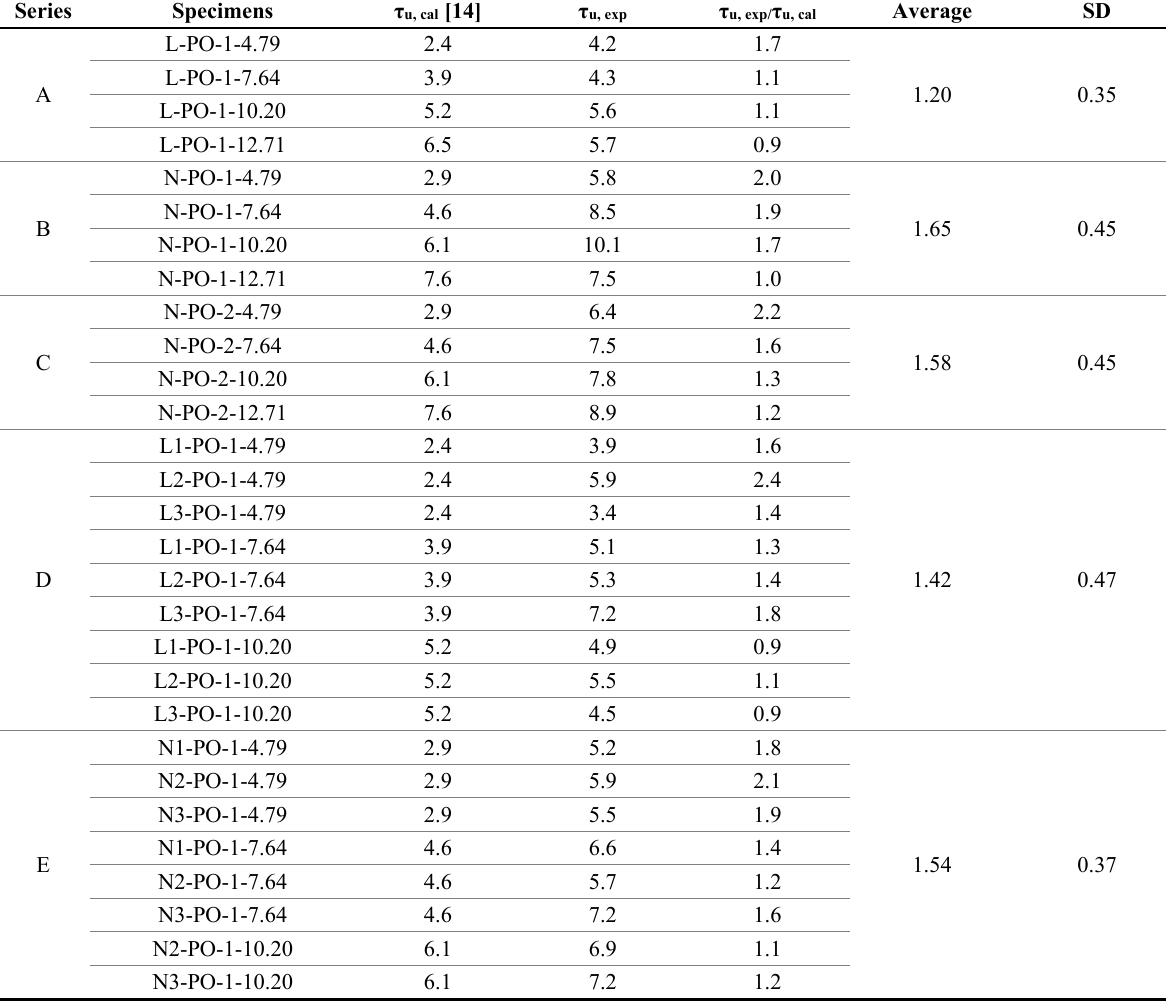
Table 4. Relationship between ultimate shear strength ( τ u, exp ) and calculated ultimate shear strength ( τ u, exp ) according to the requirements of the ACI 318